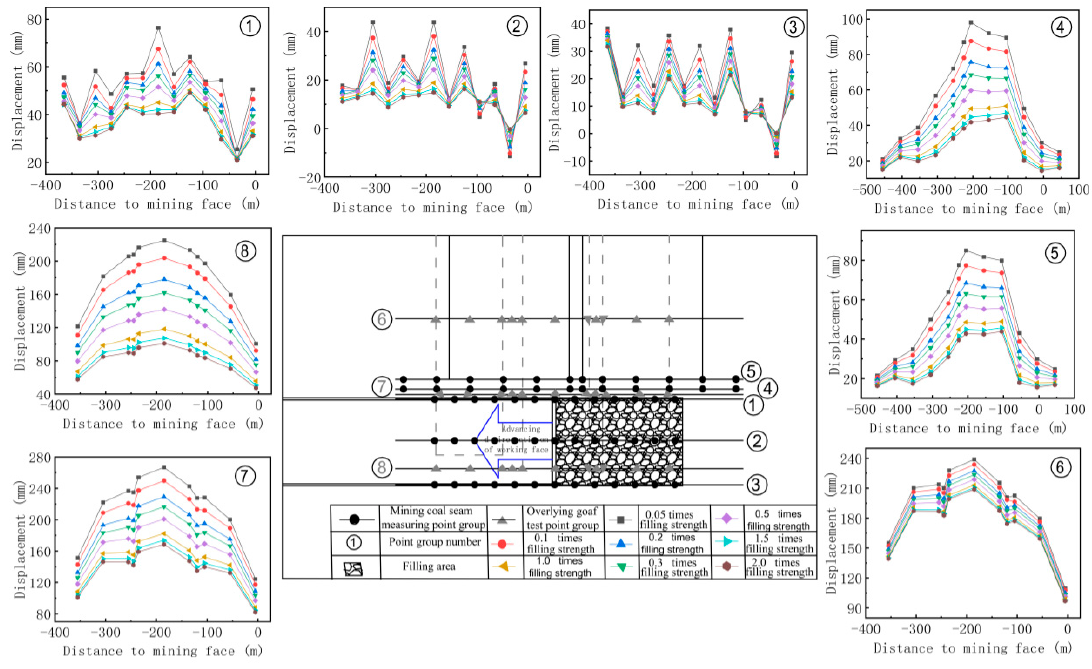
Figure 6. Movement characteristics of the coal and rock strata (360